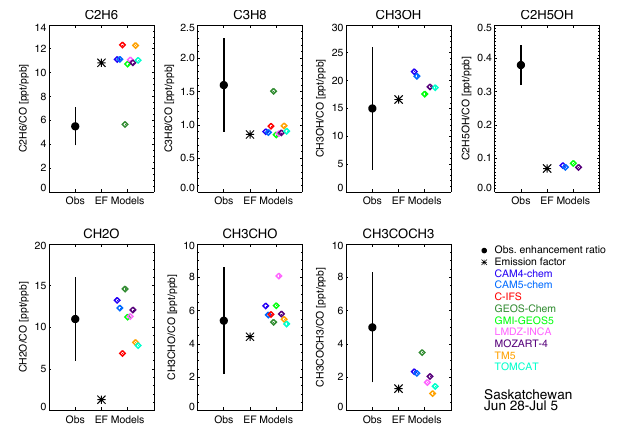
Figure 20. Correlations of VOCs to CO for the POLMIP models, compared to those derived from the DC-8 observations for the fires in Saskatchewan. The filled circle shows the enhancement ratio de- rived from DC-8 observations (Hornbrook et al., 2011). The asterisk shows the EF of the model emissions. The colored diamonds are the enhancement ratios determined for each